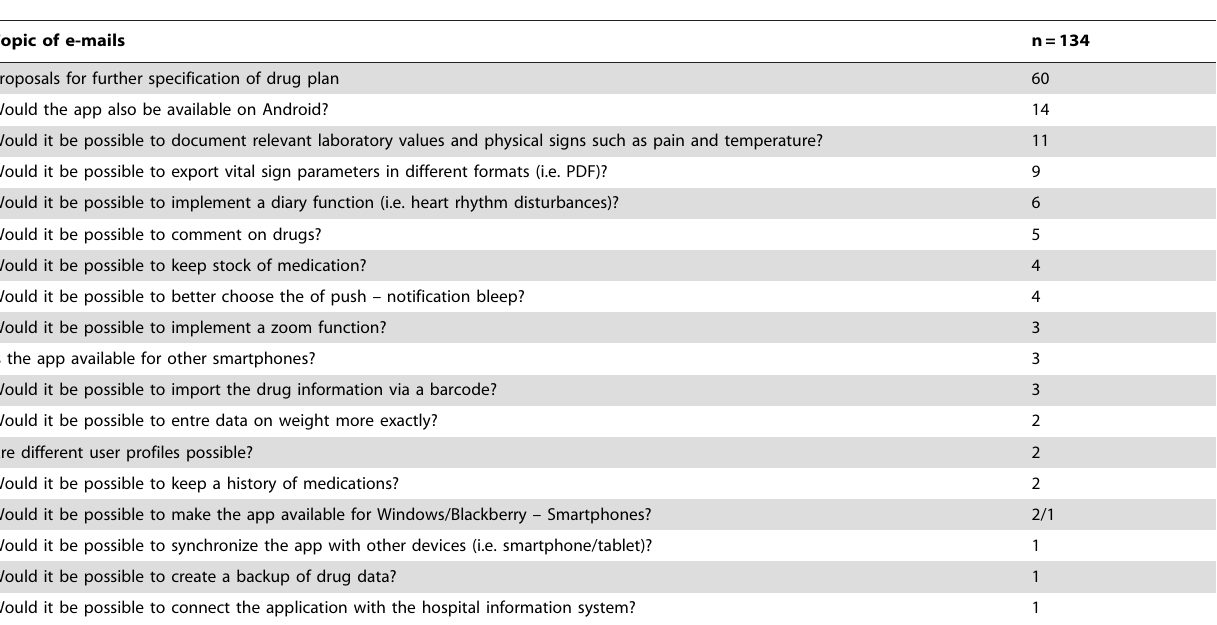
Table 3. Topics of Feedback-Mails proposing further development of the application.